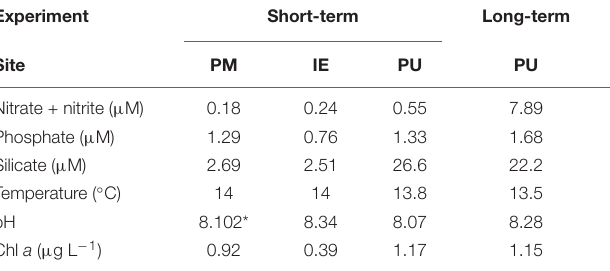
TABLE 1A | Chemical and biological characteristics of seawater collected for each experiment.